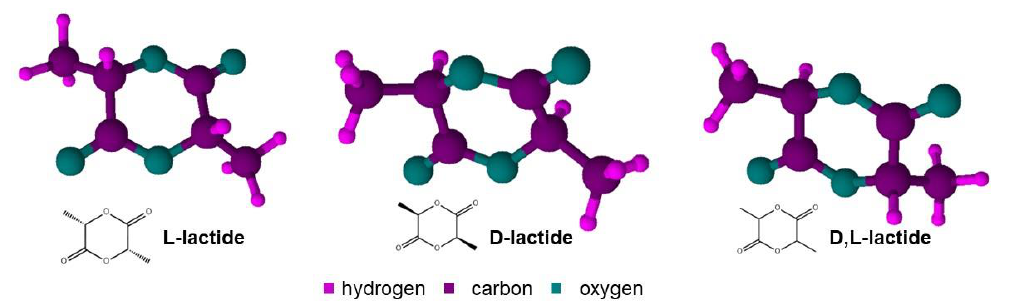
Figure 6. Chemical structure of D-, M-, and L-lactide, respectively (reprinted with permission [12], Copyright 1998 Elsevier).